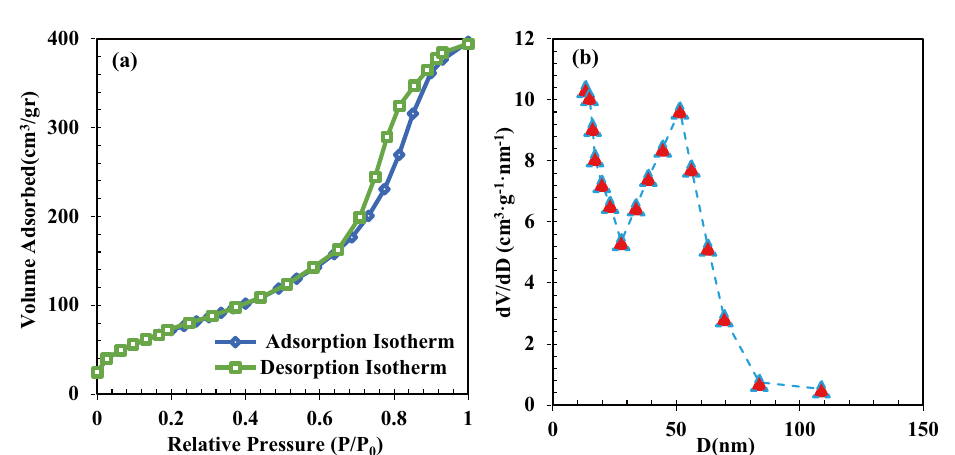
Figure 4. ( a ) N 2 adsorption–desorption hysteresis and ( b ) pore size distribution of ZrO 2 /TiO 2 /Fe 3 O 4